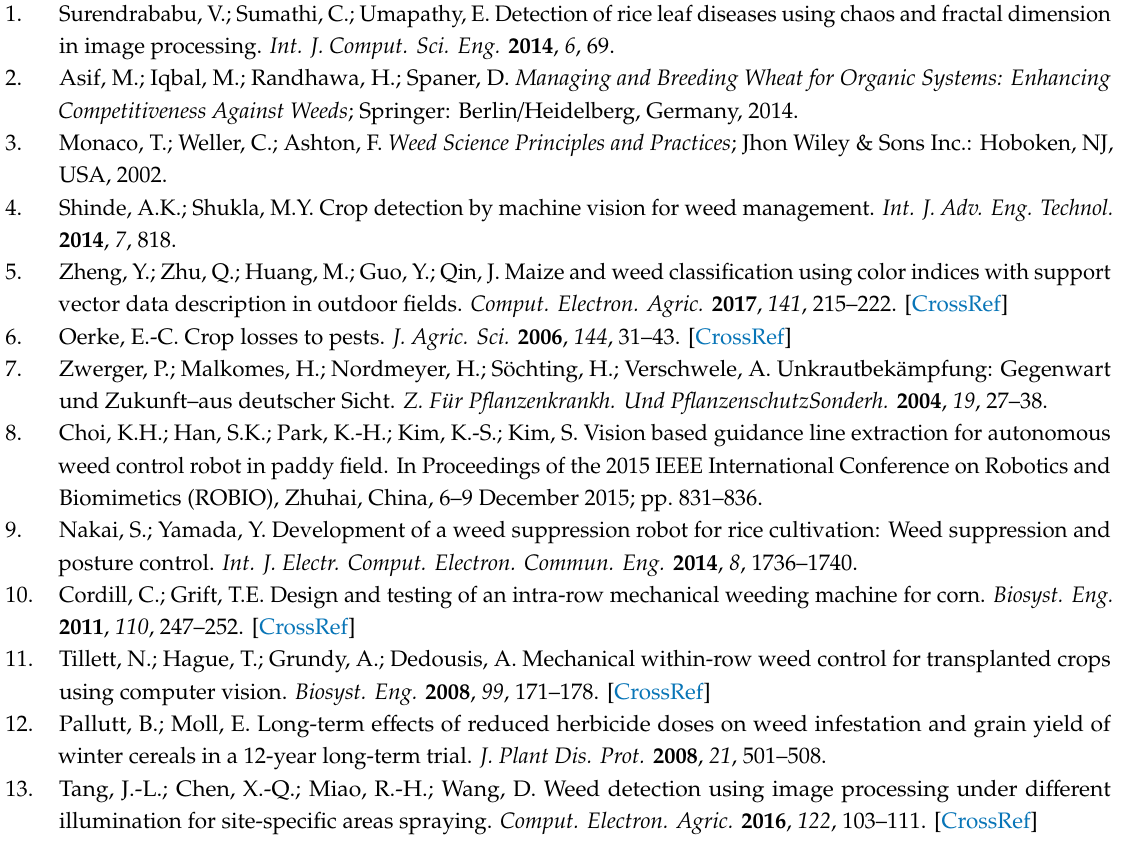
for classification of rice and